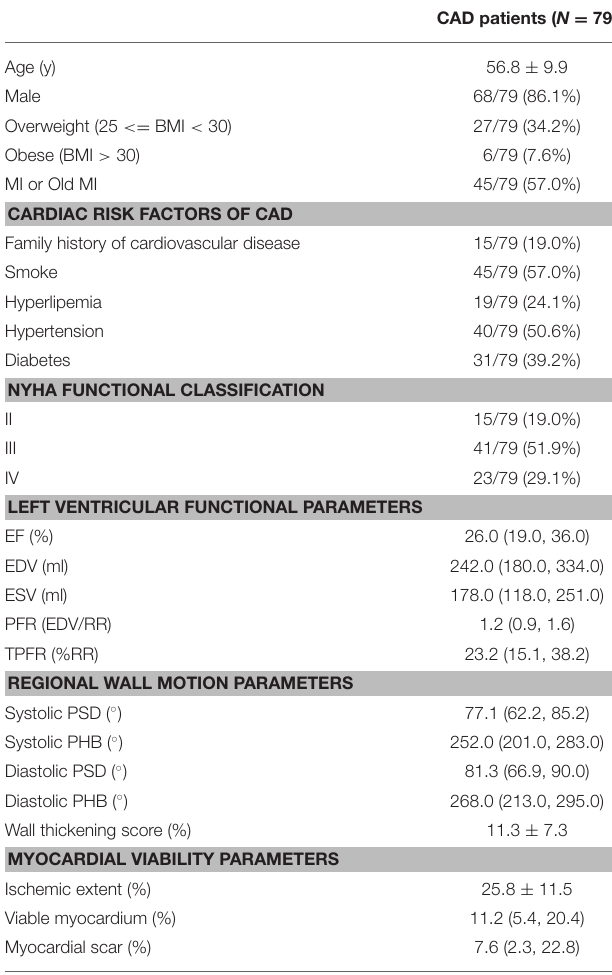
TABLE 1 | Basic characteristics of the CAD patients [proportion, mean ± SD or median (25th,